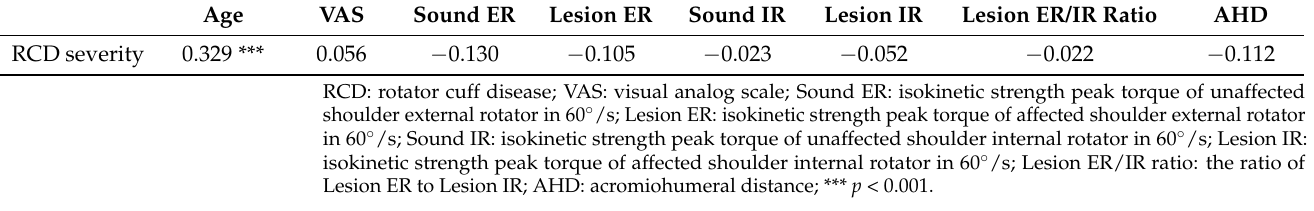
Table 4. Difference analysis according to the relevant factors of the RCD